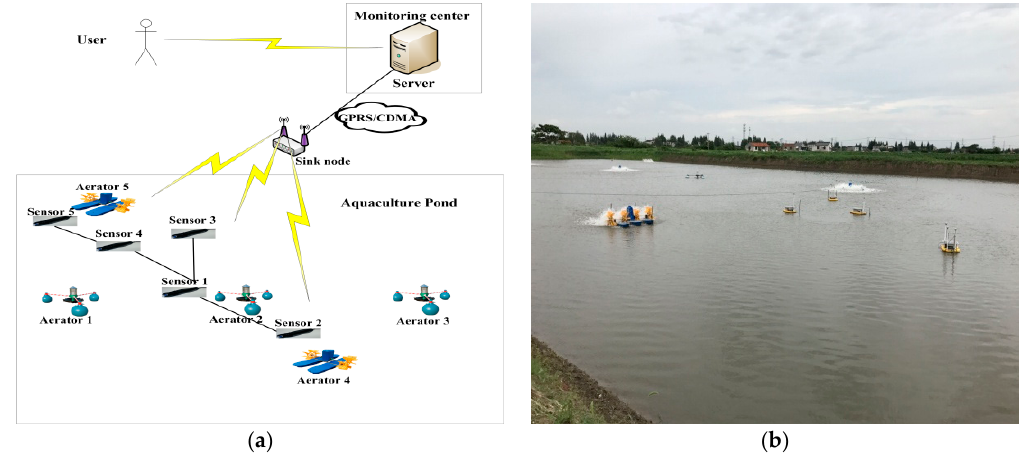
Figure 3. The topology of wireless sensor networks (WSN) monitoring system ( a ) and the field deployment of sensors ( b ).